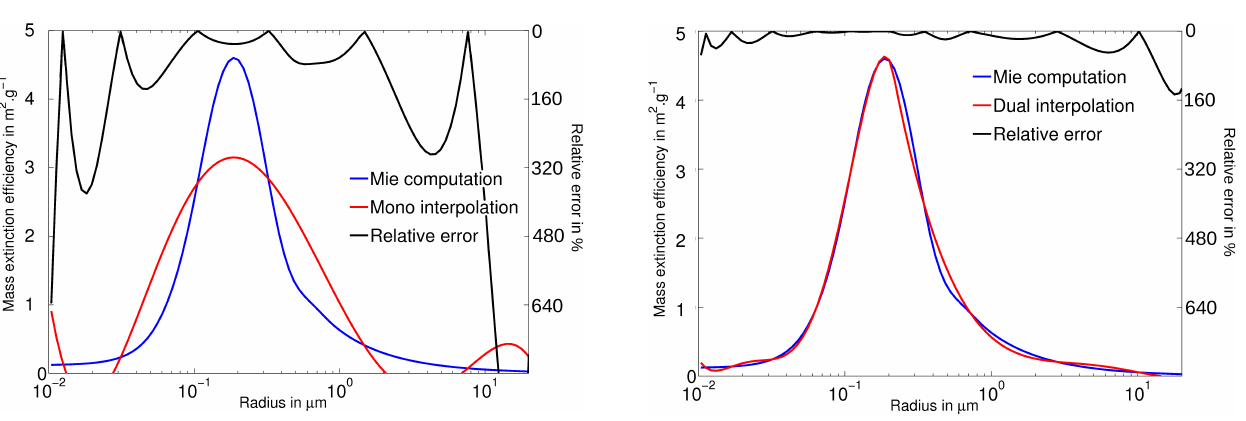
Fig. 4. Mass extinction efficiency (left) at 550nm for given values of σ and k r , k i as a function of the radius for the Mie computa- tion versus the mono polynomial interpolation and the relative error (right).